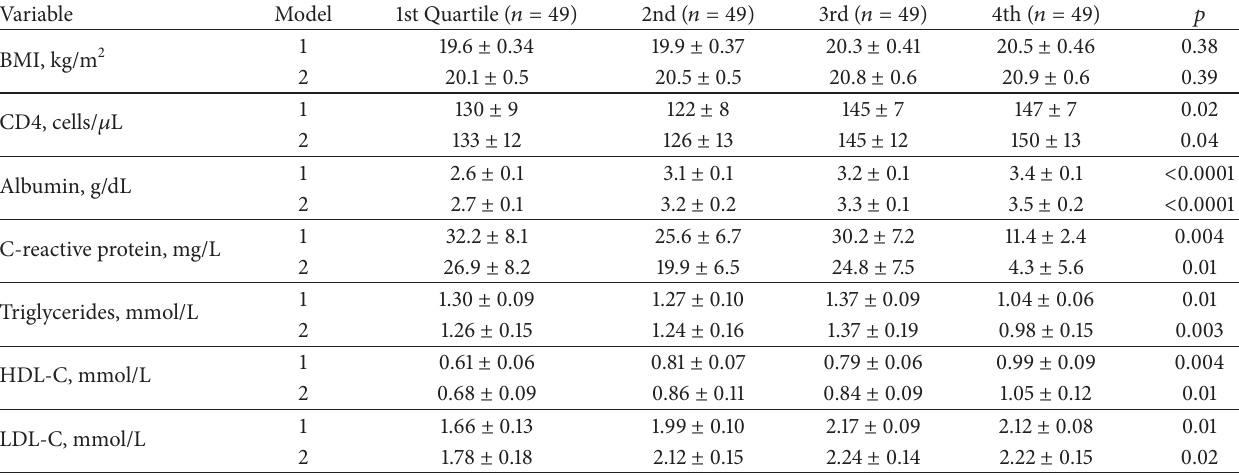
Table 3: Quartiles of plasma arachidonic acid (AA) levels and markers of cardiovascular disease and HIV/AIDS